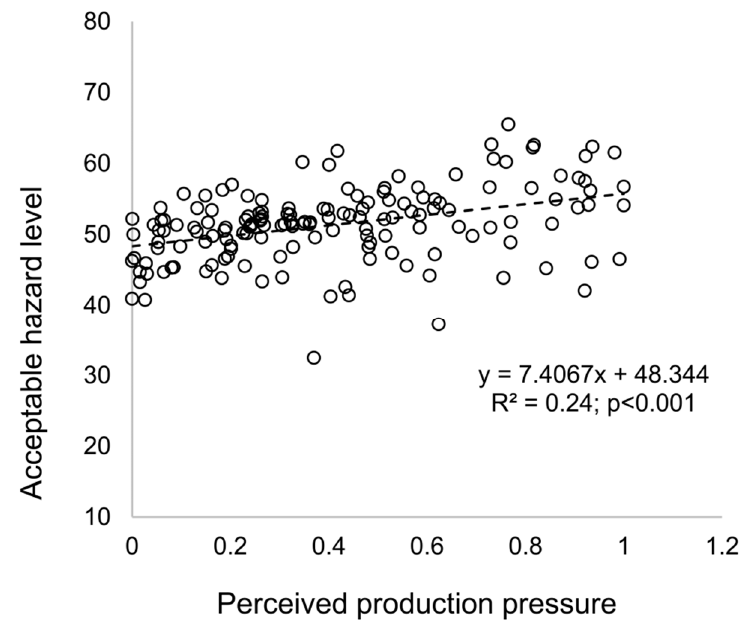
Figure 7. Relationship between the perceived production pressure and the individual acceptable hazard level.